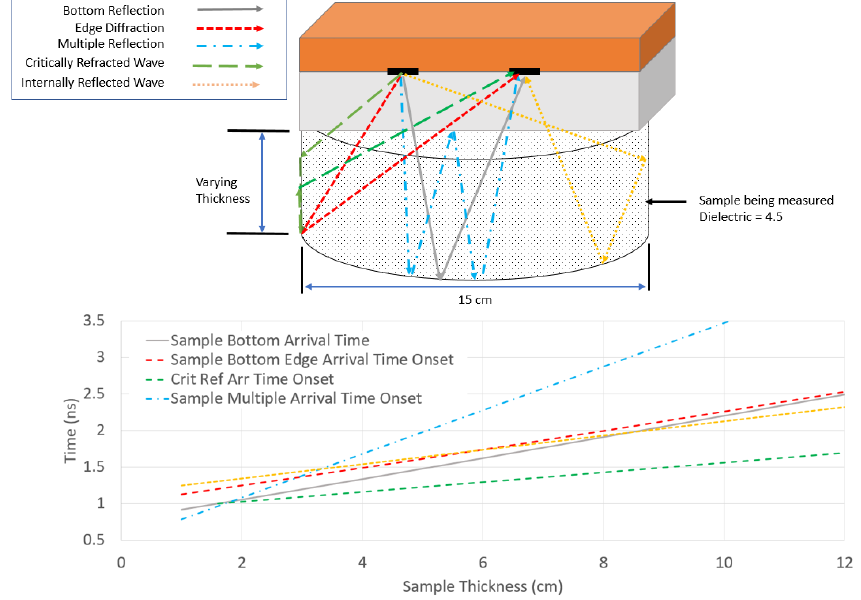
Figure 12. Chart of sample bottom reflection arrival times versus the onset of the arrivals from other reflection and diffraction paths for a 6 in (15 cm) diameter sample with varying thicknesses.